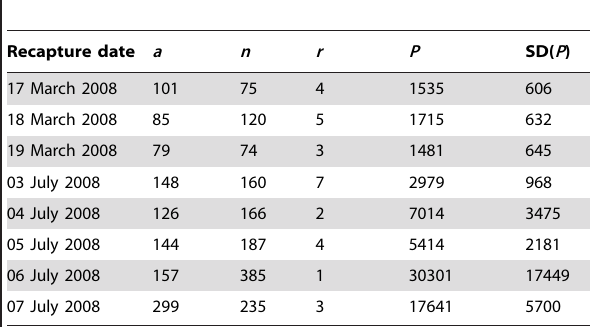
Table 2. Instantaneous Population Size Estimated via